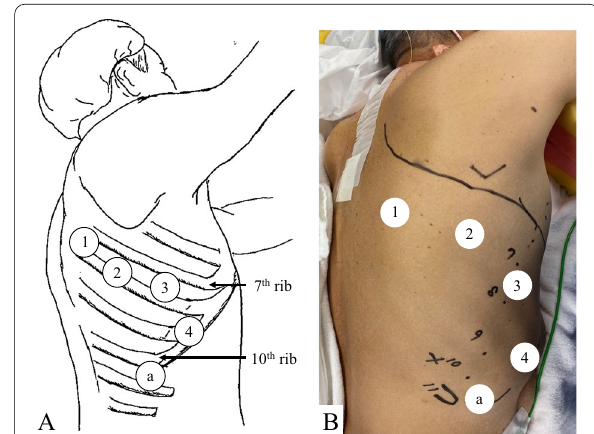
Fig. 1 A Schema of the port placement in the right chest. Ports 1–4 are for the robotic arm. The other part (a) is for the assistants. B Preoperative design of port placement in the right chest. The line over the ports 1–3 is the incision performed in the case of emergency open thoracotomy. The patient’s head is at the top of the picture and the anterior chest is to the right of the